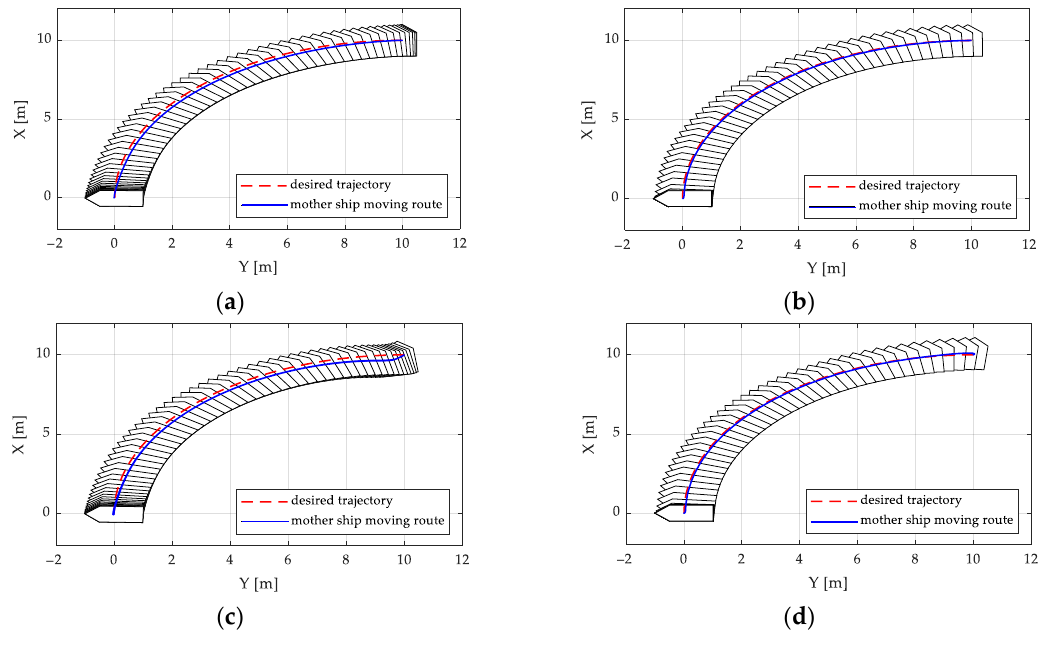
Figure 9. The trajectory tracking performance of the barge ship when conveyed by the tugboats. ( a ) Conveyed with the H ∞ controller; ( b ) conveyed with our sliding mode controller; ( c ) conveyed with the H ∞ controller under disturbance; ( d ) conveyed with our sliding mode controller under disturbance.